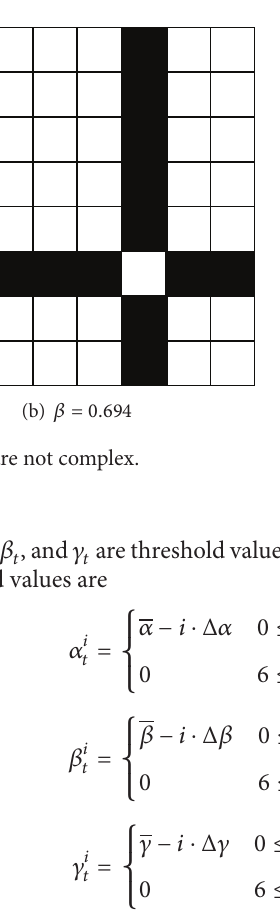
Figure 2: Blocks with large 𝛼 while not complex.